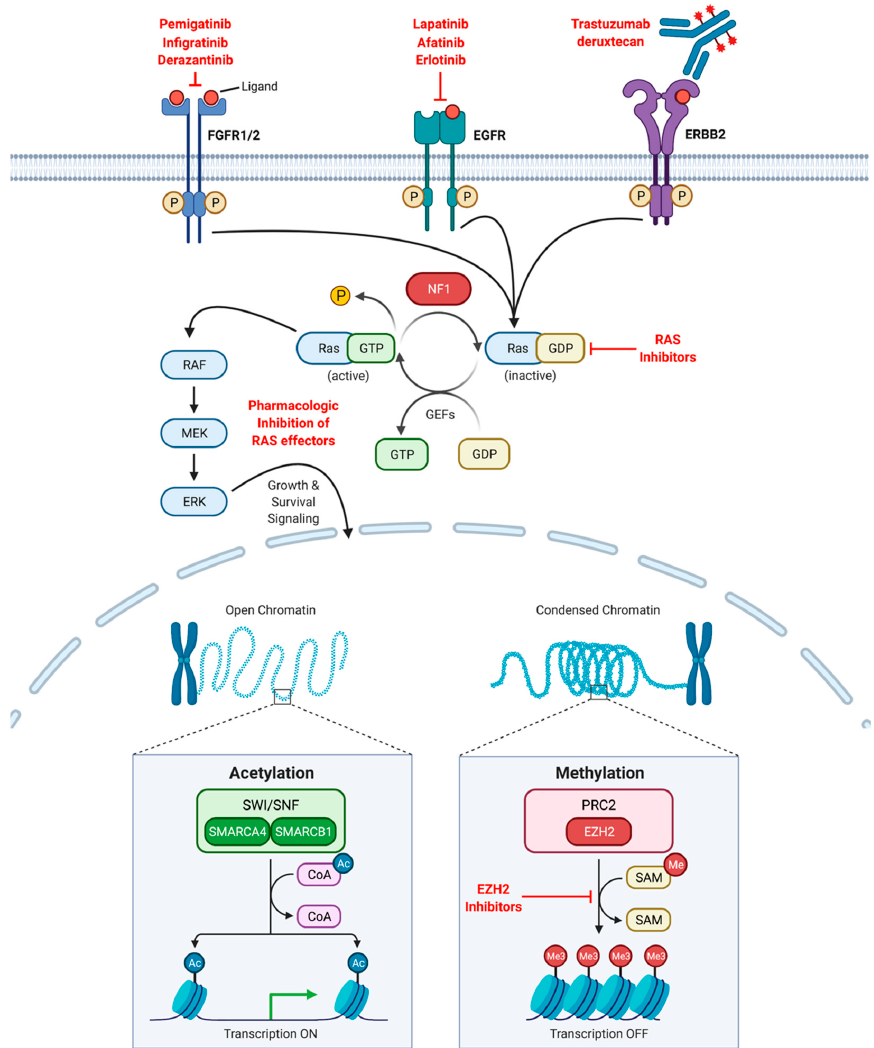
Figure 2. Potential therapeutic targets for ASCC. Cell surface receptors recurrently mutated in ASCC include fibroblast growth factor receptors 1 and 2 (FGFR1/2), epidermal growth factor receptor (EGFR) and Erb-B2 (ERBB2) receptor tyrosine kinase. These result in constitutive growth signaling. NRAS and KRAS are also recurrently mutated. RAS is activated through the exchange of guanosine diphosphate (GDP) for guanosine triphosphate (GTP) by guanine nucleotide ex- change factors (GEF). RAS typically catalyzes GTP to release a phosphate (P) residue converting it to an inactivated state. Catalysis is facilitated by GTP activating proteins such as NF-1, which is frequently inactivated in ASCC. NRAS and KRAS mutations typically result in impaired GTP ca- talysis resulting in constitutive downstream growth signaling. Under normal conditions, gene expression is regulated by both switch/sucrose nonfermentable (SWI/SNF) complex and polycomb repressor complex 2 (PRC2). Subunits of SWI/SNF, SMARCA4 and SMARCB1 are recurrently mu- tated resulting impairing histone acetyltransferase activity of SWI/SNF. This results in unopposed activity of PRC2-mediated histone methyltransferase by subunit enhancer of zeste homoglog 2 (EZH2). Indicated in red are several pharmacologic inhibitors of these pathways either in clinical practice or currently under investigation. Ac, acetyl group; CoA, coenzyme A; Me, methyl group; SAM, S -Adenosyl methionine.